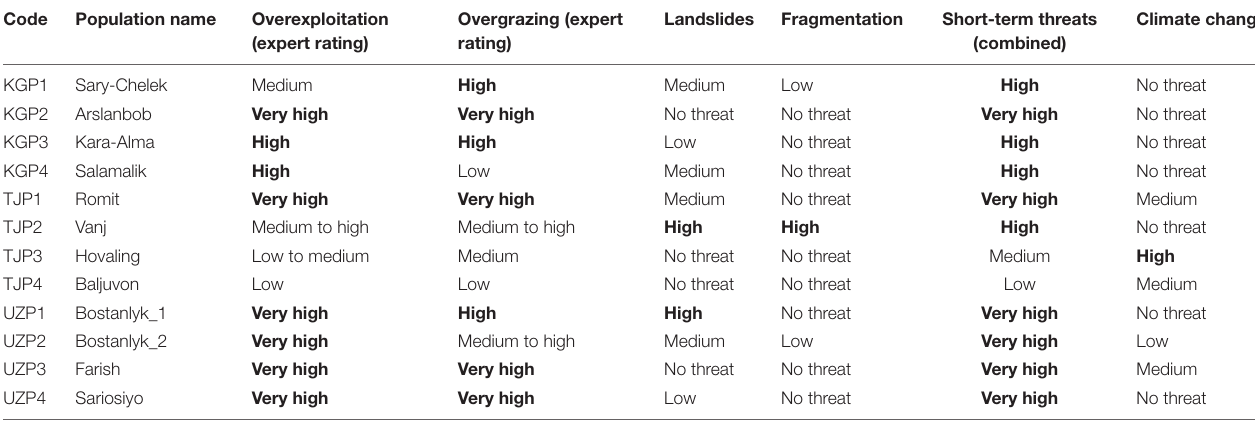
TABLE 5 | Potential threat magnitude classes for 12 wild Juglans regia L. populations.